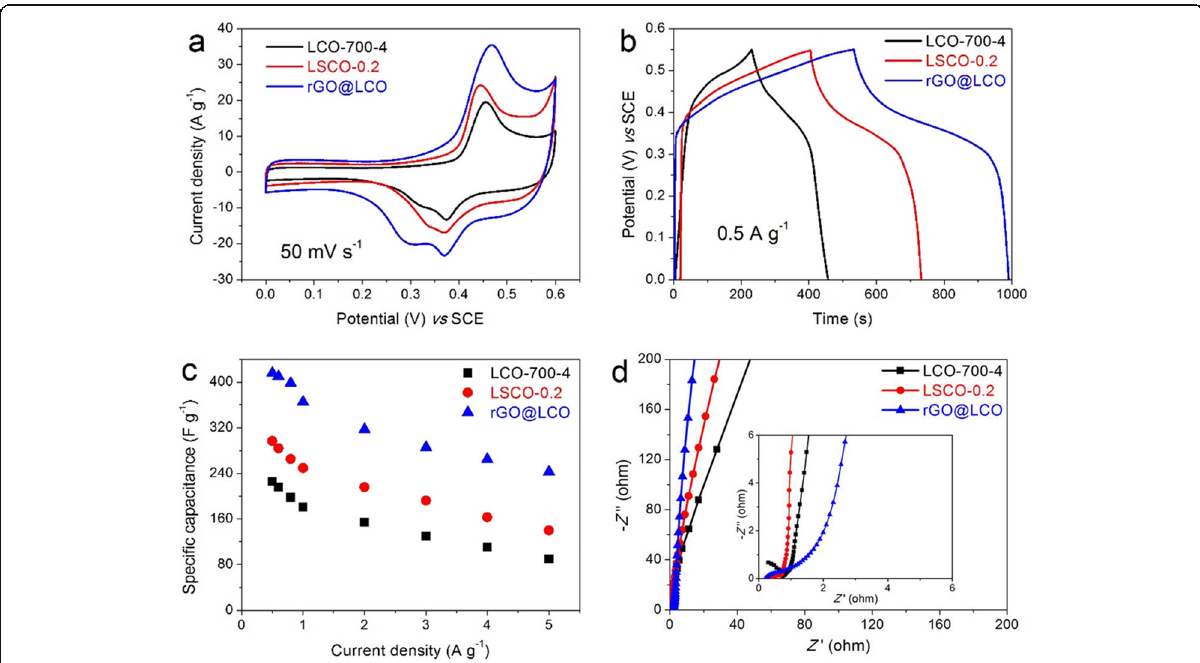
Fig. 7 a CV curves at 50 mV s − 1 , b GCD curves at 0.5 A g − 1 , c rate capability, and d Nyquist plots in the frequency range of 100 kHz to 0.01 Hz for LCO-700-4, LSCO-0.2, and rGO@LCO